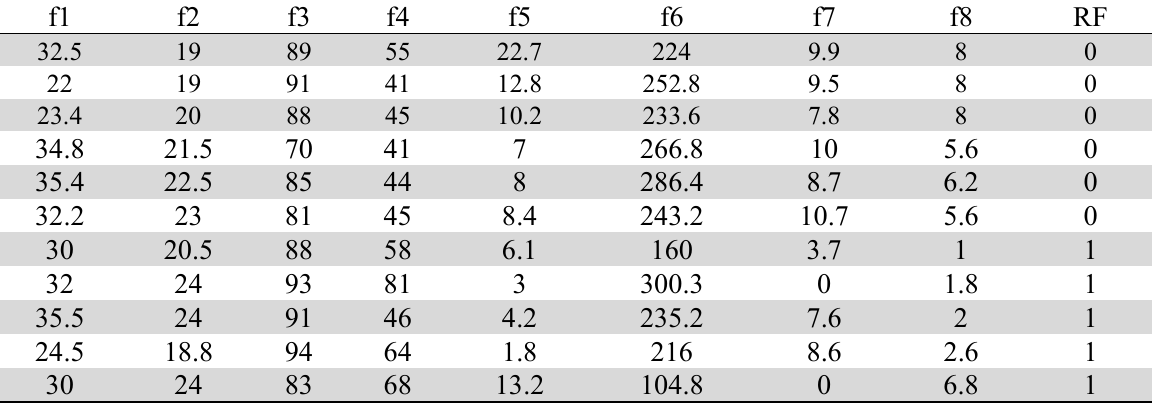
Meteorological record - rainfall data from